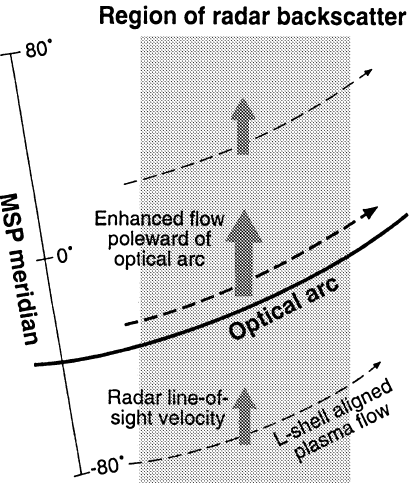
Fig. 6. A schematic representation of the relative locations of the MSP meridian and the Sunward-flow region of backscatter under the time dependent interpretation of the observations. To compare backscatter velocities with the location of the optical features observed along the MSP meridian, the arc and plasma flow must both be assumed to be L-shell aligned. In this interpretation, a velocity enhancement might be observed adjacent to and poleward of the